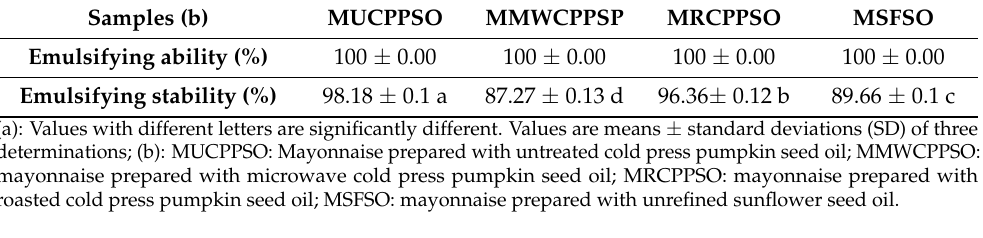
Table 2. Emulsifying properties of mayonnaise samples (a). Samples (b) MUCPPSO MMWCPPSP MRCPPSO Emulsifying ability